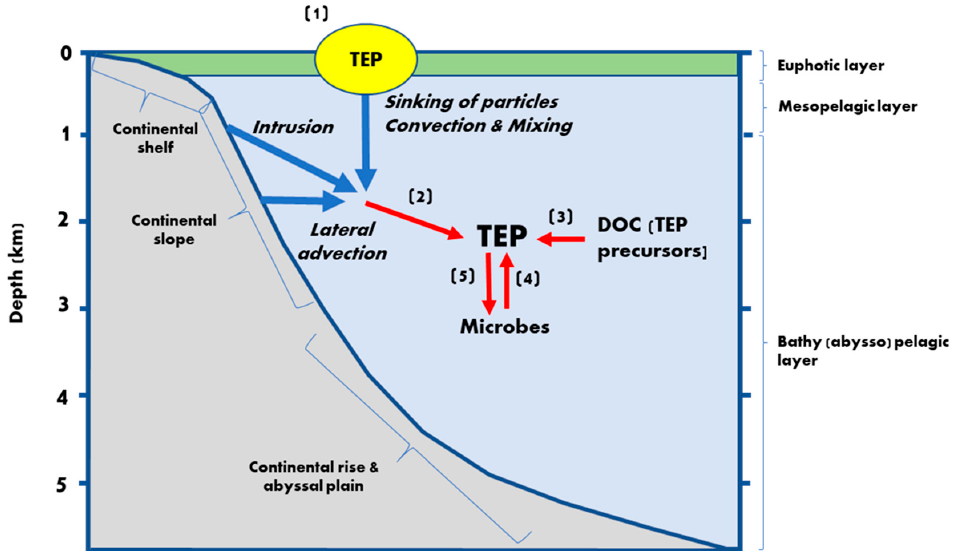
Figure 3. Schematic representation of the major processes involved in the TEP dynamics in the deep ocean. (1) TEP are mainly produced by phytoplankton and bacteria in the upper ocean [5,6]. (2) A fraction of TEP produced in the upper ocean is transported to the deeper layers. The transport processes include the sinking of particles and the advective transport due to convection and mixing, and intrusion and lateral advection. TEP transport mediated by these processes is more important in the ocean’s margins than in open ocean domains. (3) TEP may be produced by the coagulation of nanogels, which are formed via the spontaneous assembly of DOC [2–4]. The ultimate source of DOC is primary production in the upper ocean, yet chemical characteristics of DOC and mechanisms underlying the persistence of DOC over millennia are poorly understood [1,38]. (4) Microbes may produce TEP, (5) while they also consume TEP. TEP are colonized by prokaryotes, acting as “hot spots” of microbes in deep oceans.